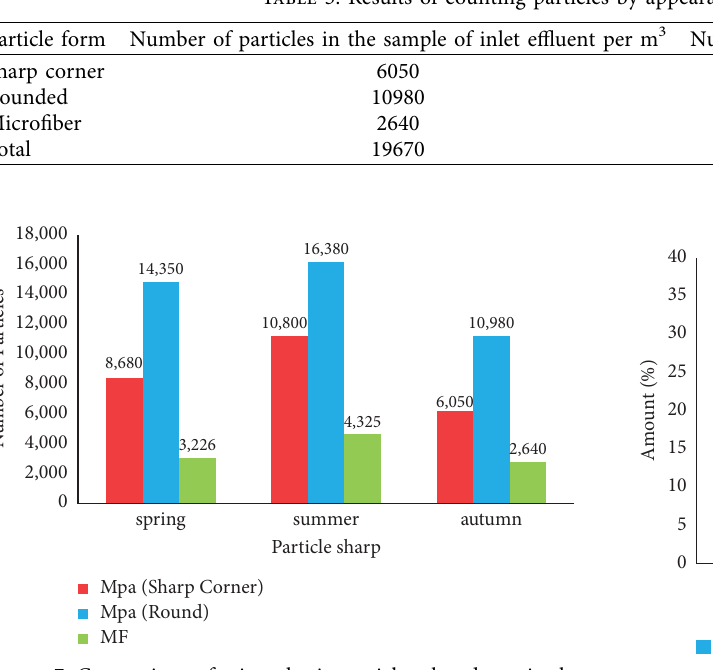
Figure 8: Determination of particle size based on the order of